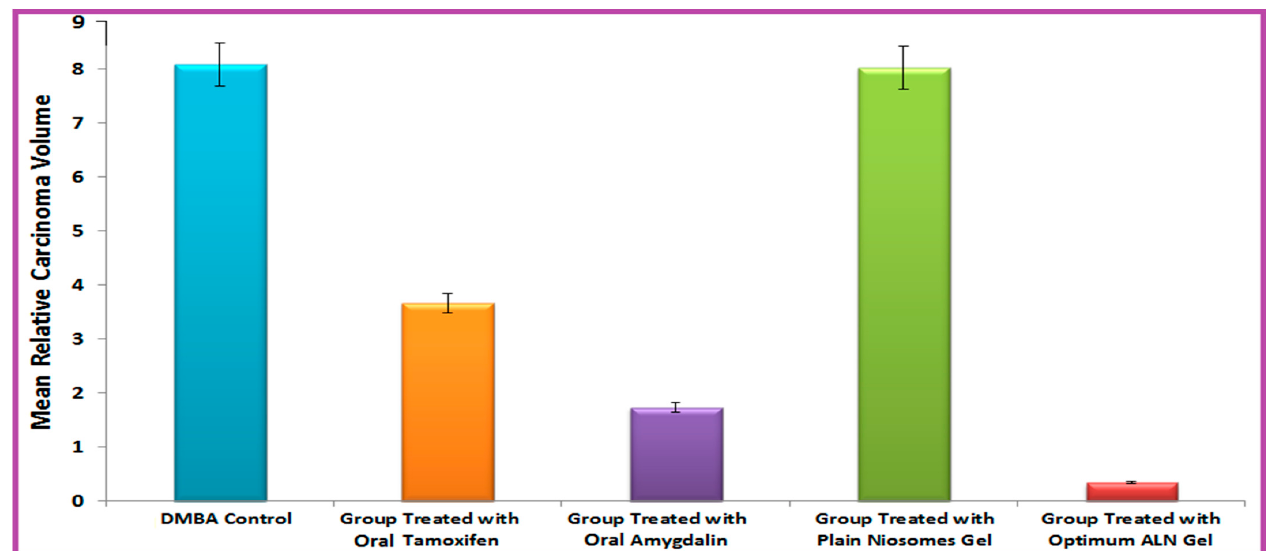
Figure 6. Treatment efficiency of optimum ALN gel formulation.